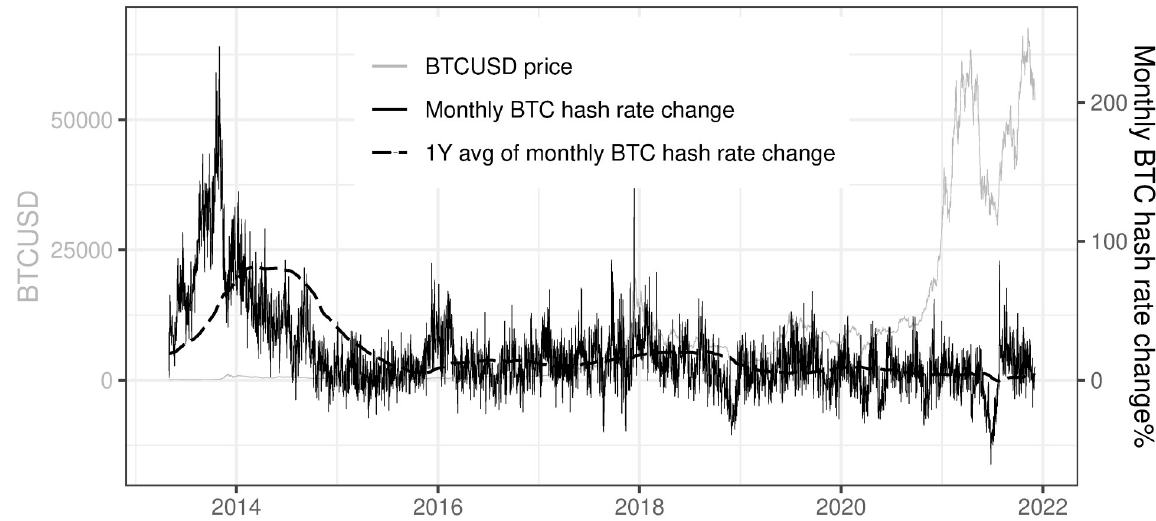
Fig 11. Monthly BTC hash rate change% and 1Y average of these changes. Note: Data covers the period between 2013/05/01 to 2021/12/03. Source: https://api.blockchain.info/charts/hash-rate?format=csv.